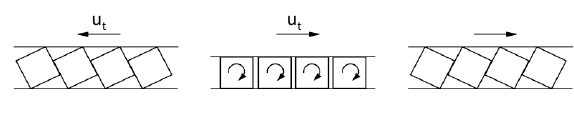
< σ < σ ) depending on the tangential displacement u 1 2 3